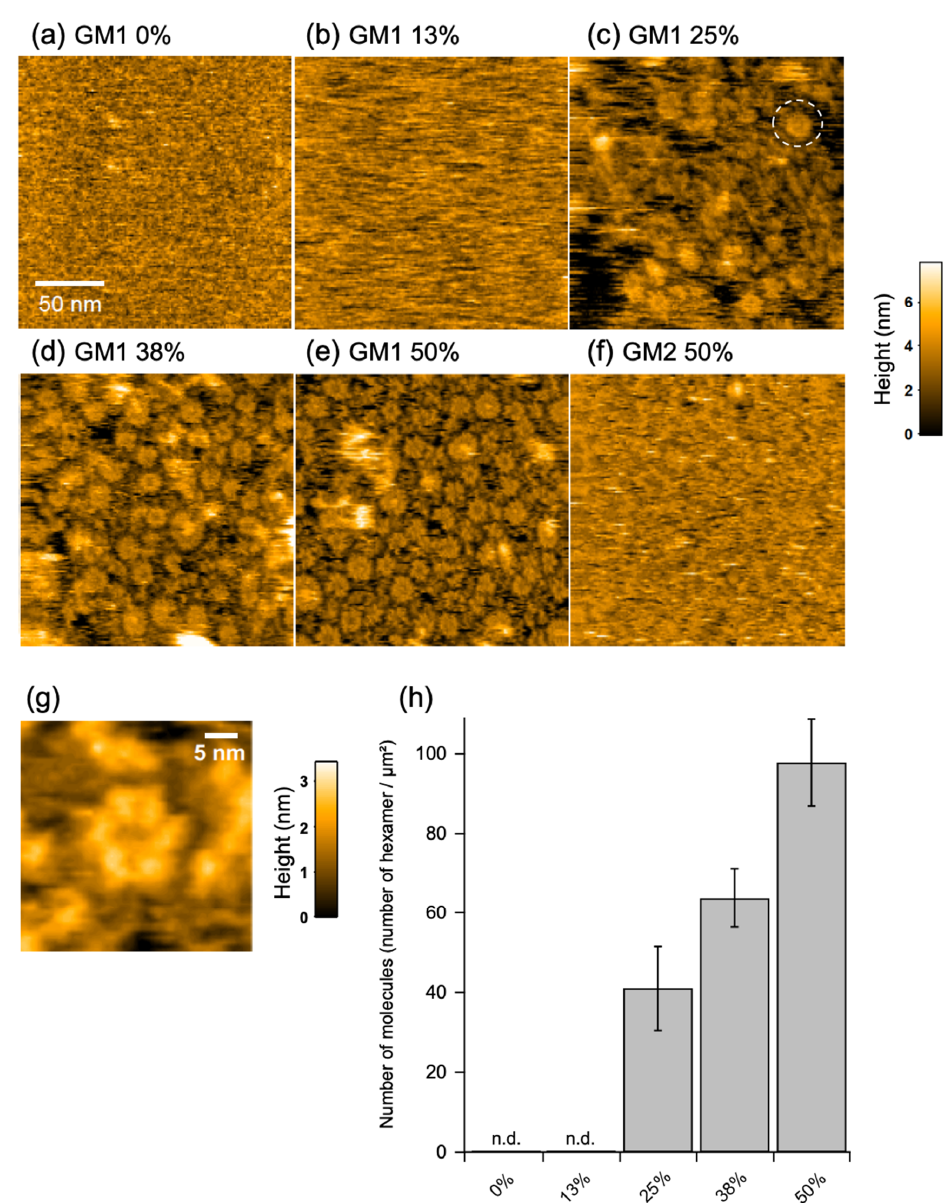
Figure 2. High-speed atomic force microscopy (HS-AFM) observation of assembly of GB2 on membranes. HS-AFM images of immunoglobulin G (IgG) on the GM1-incorporated 1,2-dioleoyl-sn- glycero-3-phosphocholine (DOPC) membranes containing ( a ) 0%, ( b ) 13%, ( c ) 25%, ( d ) 38%, and ( e ) 50% GM1 and ( f ) 50% GM2. A typical IgG hexameric ring is indicated by dotted circles. ( g ) A high- resolution image of IgG hexamer. ( h ) Summary of the number of IgG hexamers counted in the HS- AFM